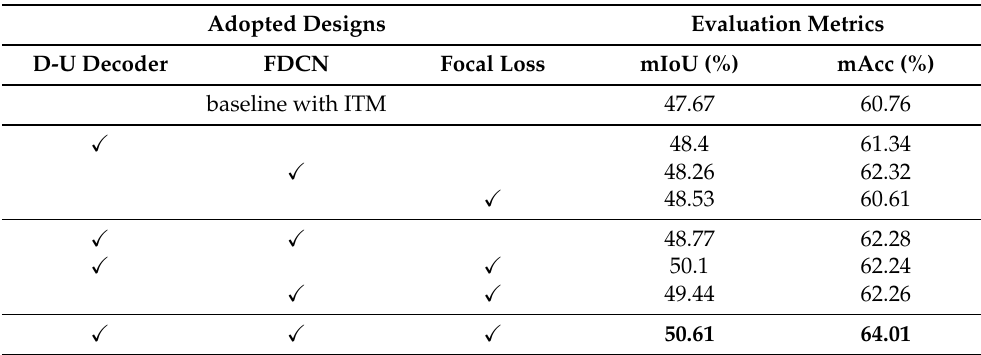
Table 3. Ablation Analysis of the proposed designs on the LoveDA dataset. The maximum value of each column is shown in